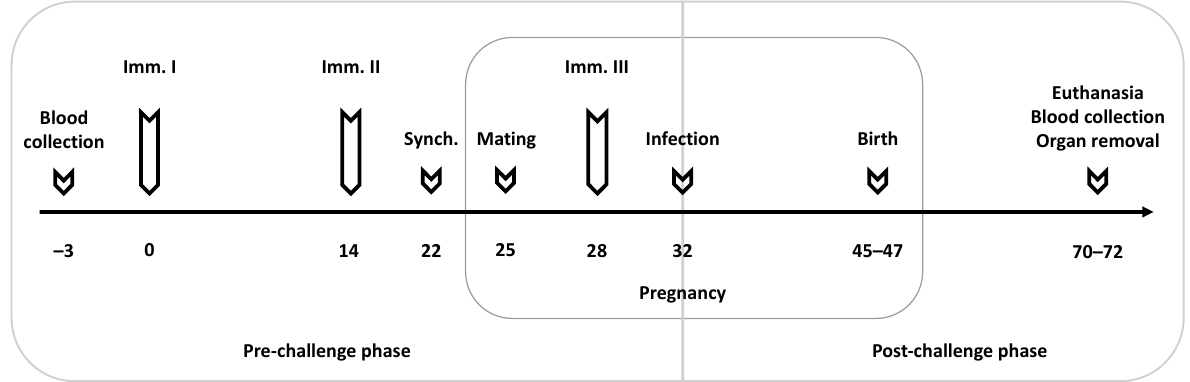
Figure 1. Timeline of the vaccination experiment. Mice were immunized three times at two ‐ week intervals with the third immunization shortly after mating (Imm. 1–3). Eight days post ‐ second immunization, mice were oestrus ‐ synchronized (Synch.) before two females and one male were put together for mating. Seven days post mating, all mice, except of the negative control (C ‐ ), were challenged with a sublethal dose of 1 × 10 5 NcSpain ‐ 7 tachyzoites. Mice were monitored daily for clinical signs, and neonatal and postnatal mortality rates were recorded. Non ‐ pregnant mice, dams and pups were euthanized between day 70–72, corresponding to 25 days p.p.